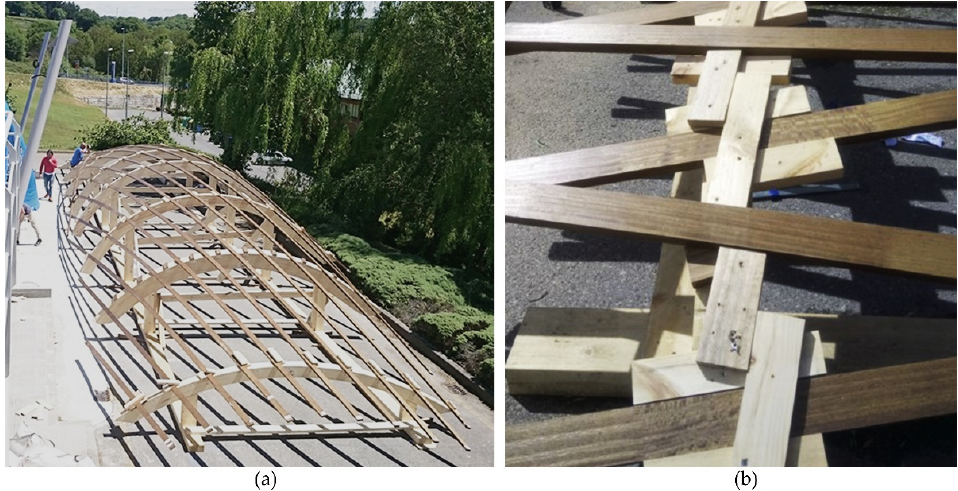
Figure 26. Gridshell during construction: ( a ) Curving process of the first family of laths; ( b ) Detail of the placement of the laths on the formwork.